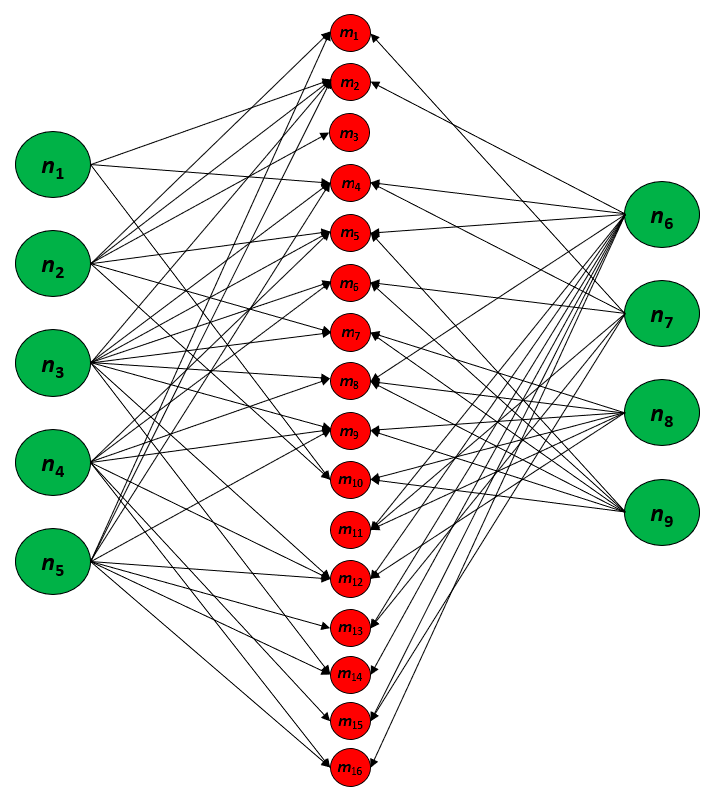
Figure 8. Graphical interpretation of the solution for Variant #2.